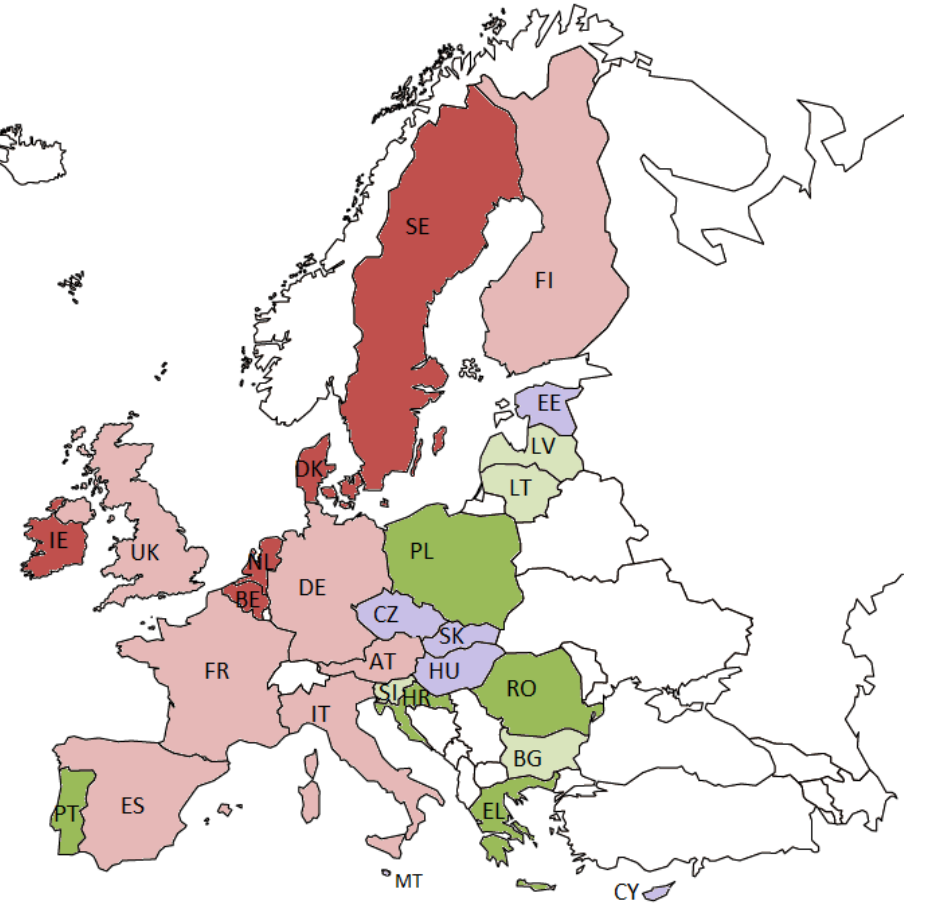
Figure 4. Geographical distribution of Member States belonging to groups A, B and